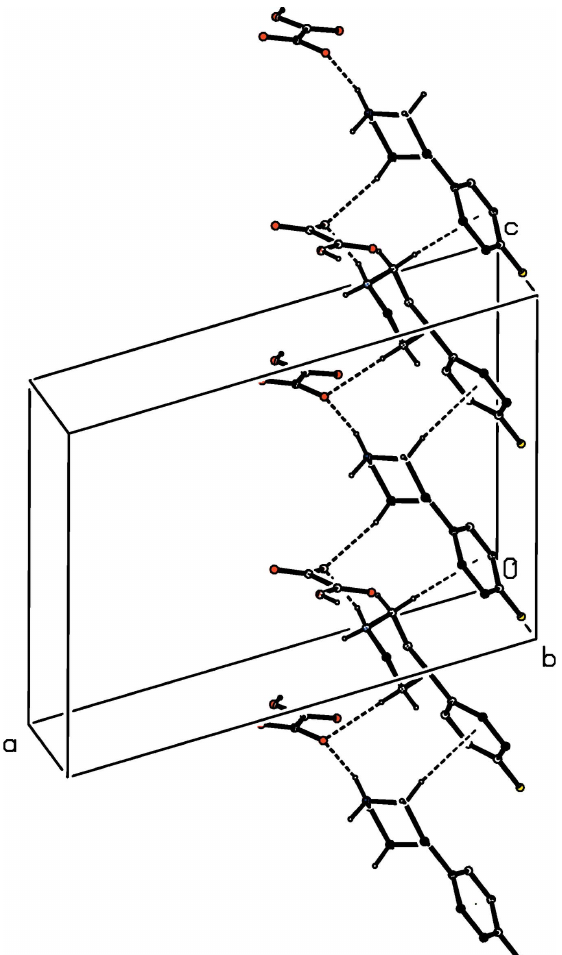
Figure 6 Part of the crystal structure of compound (II) showing the formation of a chain of rings running parallel to the [001] direction and built from C— H (cid:2)(cid:2)(cid:2) O and C—H (cid:2)(cid:2)(cid:2) (cid:2) (arene) hydrogen bonds. Hydrogen bonds are drawn as dashed lines and, for the sake of clarity, the H atoms bonded to the C atoms not involved in the motif shown have been omitted.